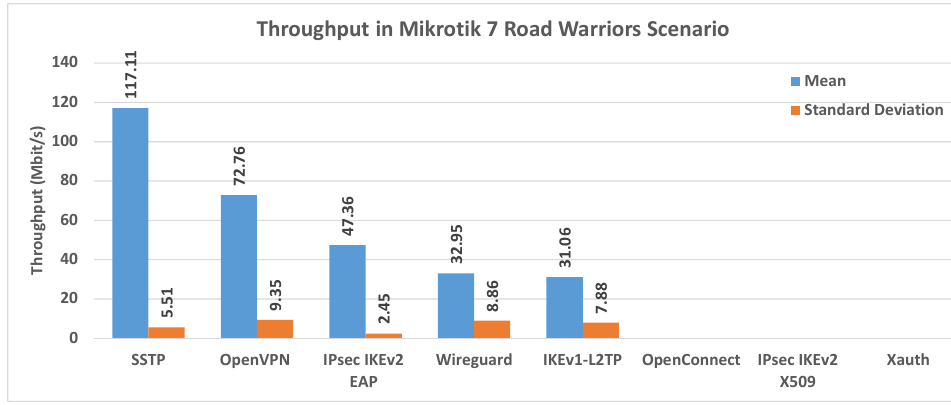
Figure 17. Comparison of Throughputs on Mikrotik 7 in all scenarios.